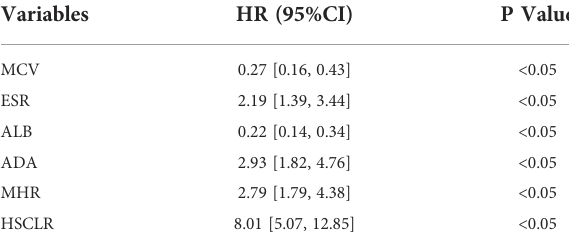
TABLE 2 Signi fi cant indexes in the multivariable logistic regression